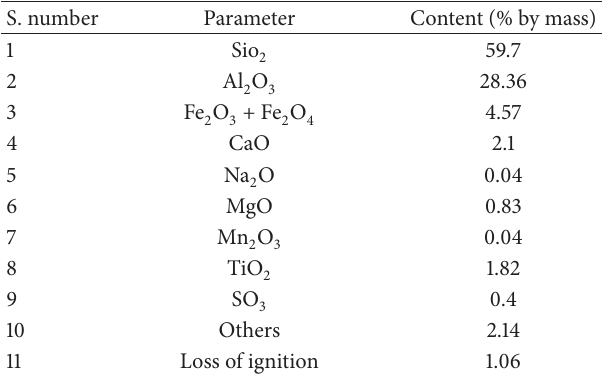
Table 1: Chemical composition of fly ash.